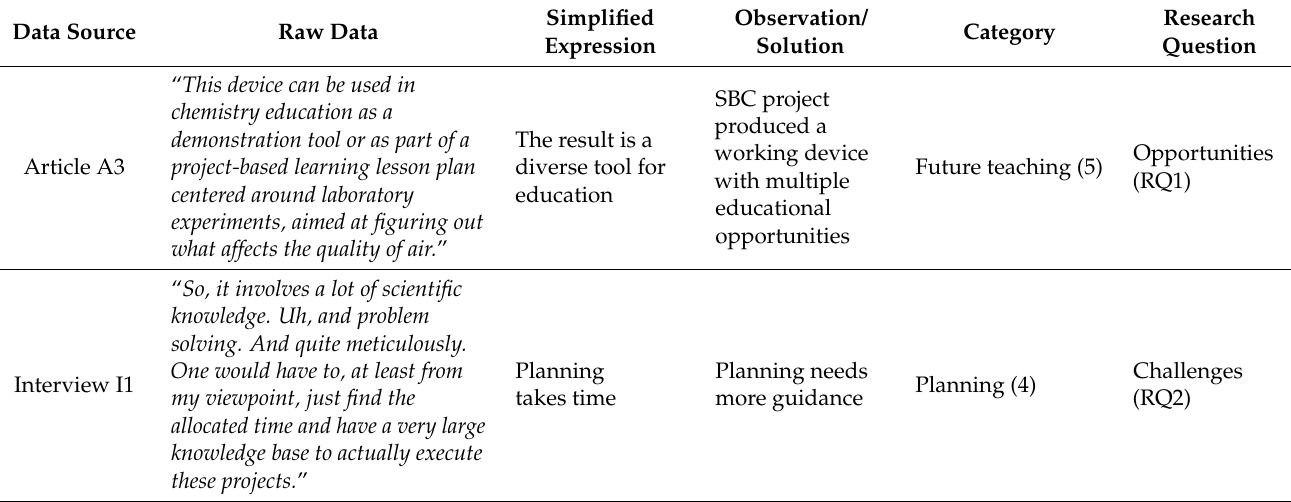
Table 1. Inductive contents